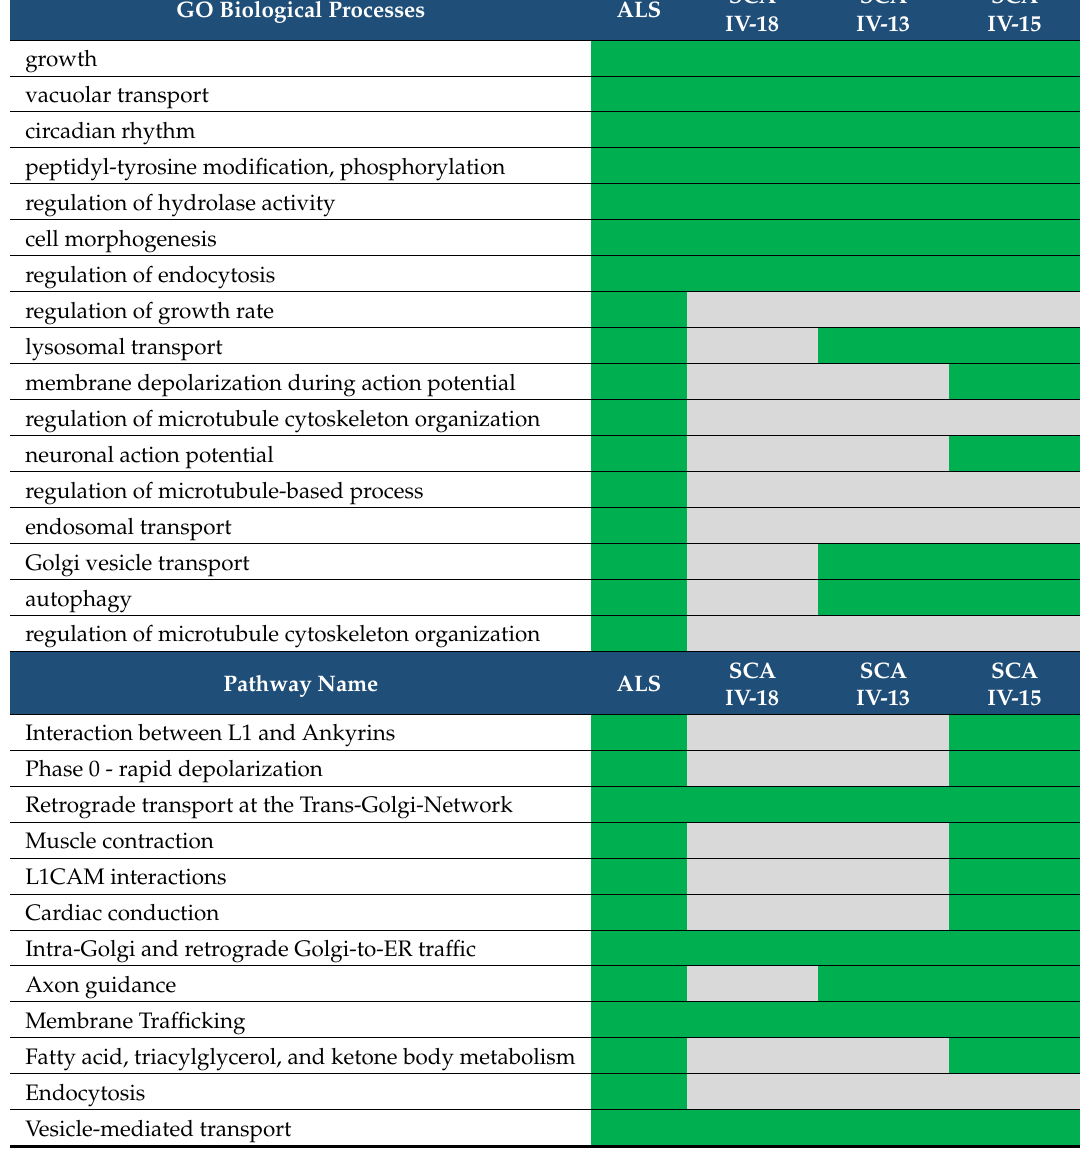
Table 3. Functional enrichment analysis of CNV-associated gene sets in ALS and SCA1-MN